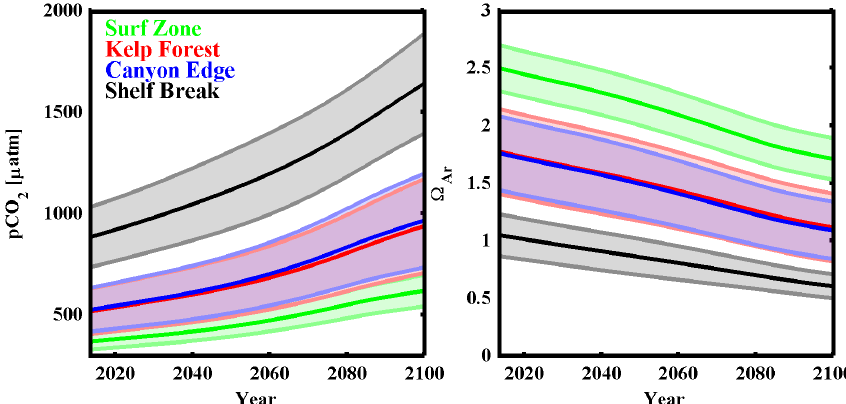
Figure 12. Projected p CO 2 (left) and (cid:127) Ar (right) between 2013 and 2100 under the IPCC RCP6.0 scenario. The solid line and the shaded region represent the mean and ± 1SD,